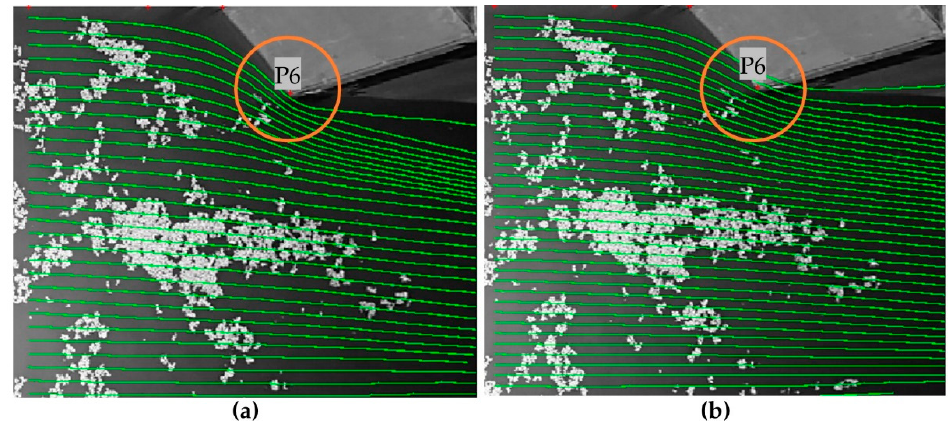
Figure 12. The flow field in a contraction when B 2 /B 1 = 0.75: ( a ) streamlines when IA = 60 pixels; ( b ) streamlines when IA = 80 pixels.